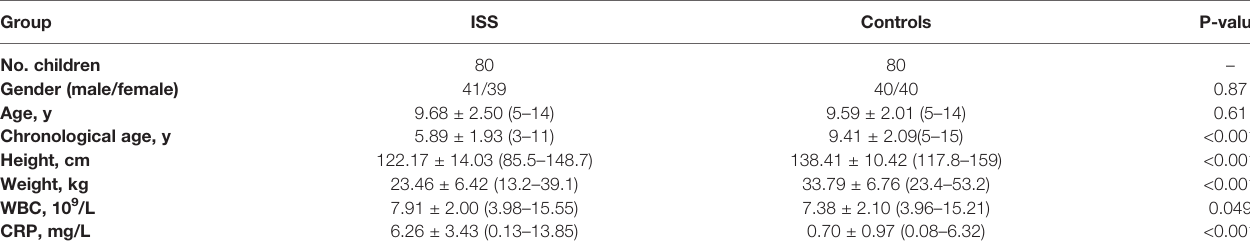
TABLE 1 | Comparison of patients with ISS and normal control individuals (NC).